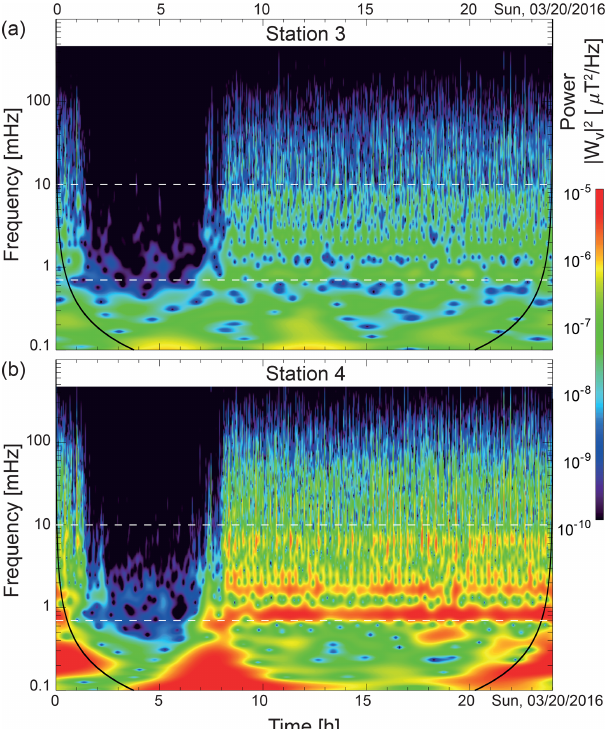
Figure 5. Distributions for 24h, daytime, and nighttime magnetic field observations with typical fluctuation amplitudes, σ , computed for each period. Additionally, the amplitude of typical nighttime fluctuations is computed using a 20min sliding window, (cid:104) σ (cid:105) , and demonstrates that nighttime observations are nonstationary with several discrete peaks. Daytime fluctuations follow broad distribu- tions. The variance of the distributions increases as the distance from the BART train line decreases.